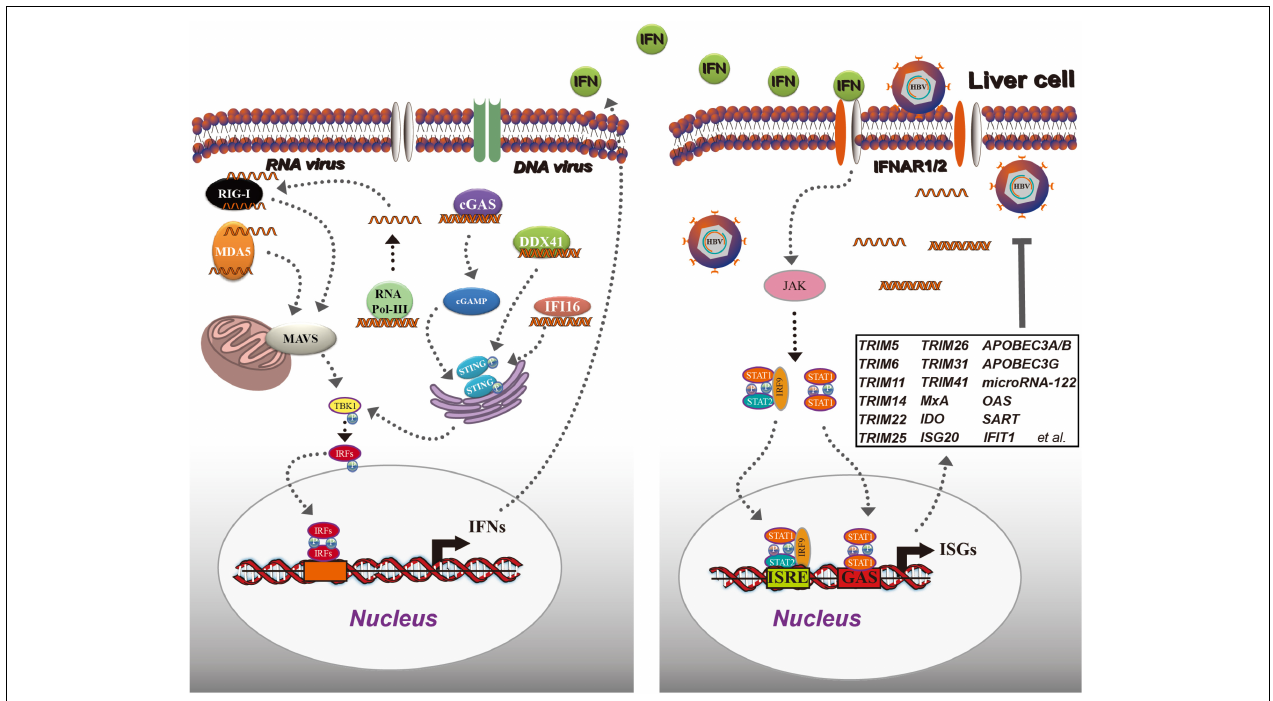
FIGURE 3 | Classical interferon (IFN) and IFN-stimulated gene (ISG) induction in response to viral infection. In the cytoplasm, viral DNA is recognized by cGAS, DDX41, or IFI16, leading to the activation of STING, which further recruits TBK1 for IRF activation and translocates to the nucleus to initiate IFN production. Viral RNA is detected by RIG-I and MDA5, and recruits another adaptor protein: MAVS (IPS-1), resulting in TBK1 activation, IRF phosphorylation, and IFN induction. Then, IFNs are secreted from the cells and bind to IFNAR1/2, leading to JAK/STAT activation. The activated ISGF3 trimer or STAT1 dimer bind to the ISRE or GAS sequence and promote the expression of ISGs. ISGs inhibit HBV as shown in the black box . cGAS, cyclic GMP-AMP synthase; DDX41, DEAD-box protein 41; IFI16, γ -IFN-inducible protein 16; STING, stimulator of IFN genes; TBK1, TANK-binding kinase 1; IFNAR1, type I IFN receptor 1; JAK, Janus tyrosine kinase; STAT, signal transducer and activator of